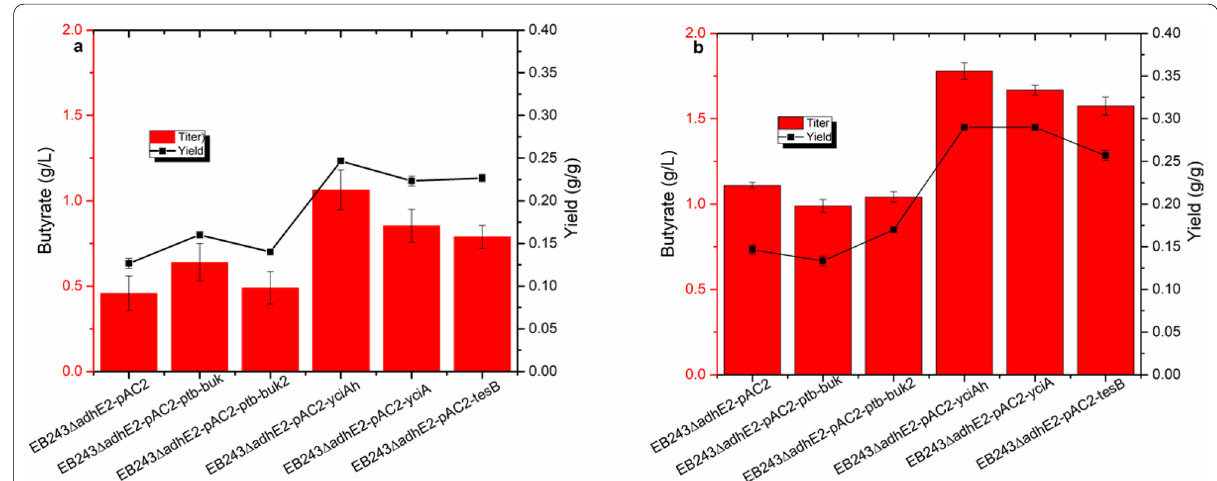
Fig. 2 Effects of overexpressing different butyrate-biosynthesis genes on the product titer. In a the strains were cultured in 10 mL polypropylene centrifuge tubes containing 5 mL of M9Y medium, while in b the strains were cultured in 50 mL polypropylene centrifuge tubes containing 5 mL of M9Y medium. The designation “ yciAh ” represents a synthesized version of the yciA gene from Haemophilus influenzae . The data represent the means SD from three biological ±